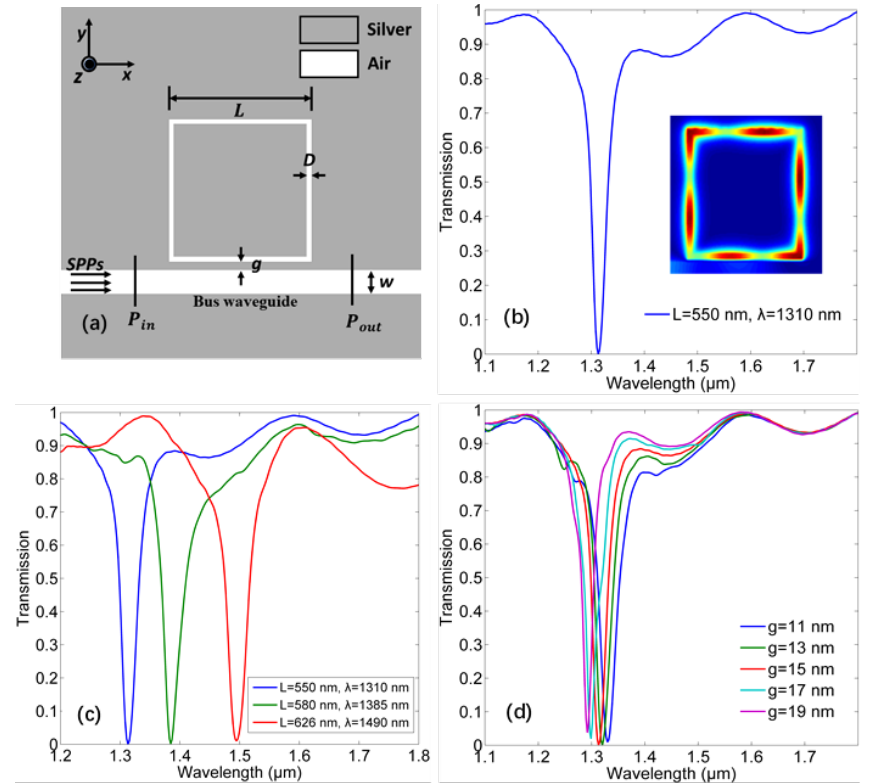
Figure 1. ( a ) Two-dimensional (2D) structure of the band-stop filter with a single square ring resonator (SRR). L = 550 nm, D = 20 nm, w = 100 nm, g = 15 nm. ( b ) The transmission spectra of the band-stop filter. The inset is the corresponding field distribution. ( c ) The transmission spectra pertinent to different side lengths L of the SRR. ( d ) The transmission spectra pertinent to different gaps g .